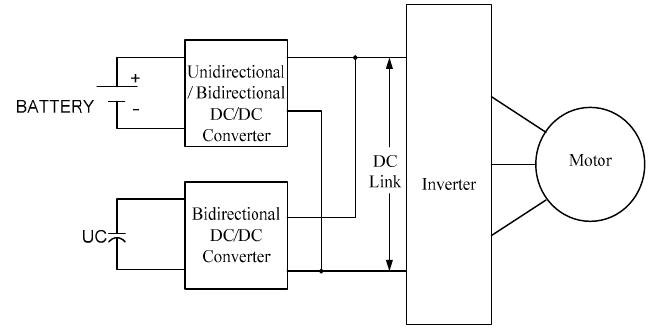
Figure 10. Multiple DC/DC converter design.